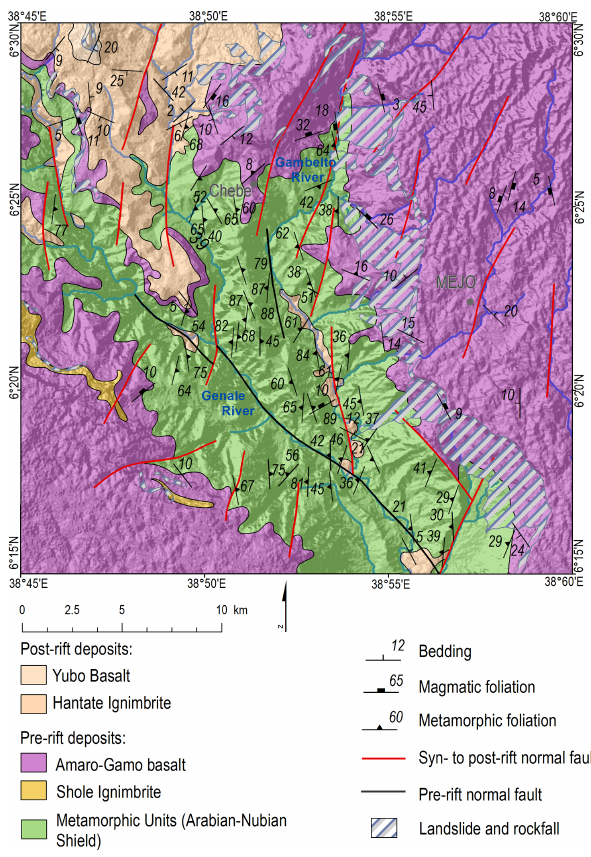
Figure 9. Geological and tectonic map of the Mejo site, with land- slides and rockfalls indicated. For the location, see Fig.